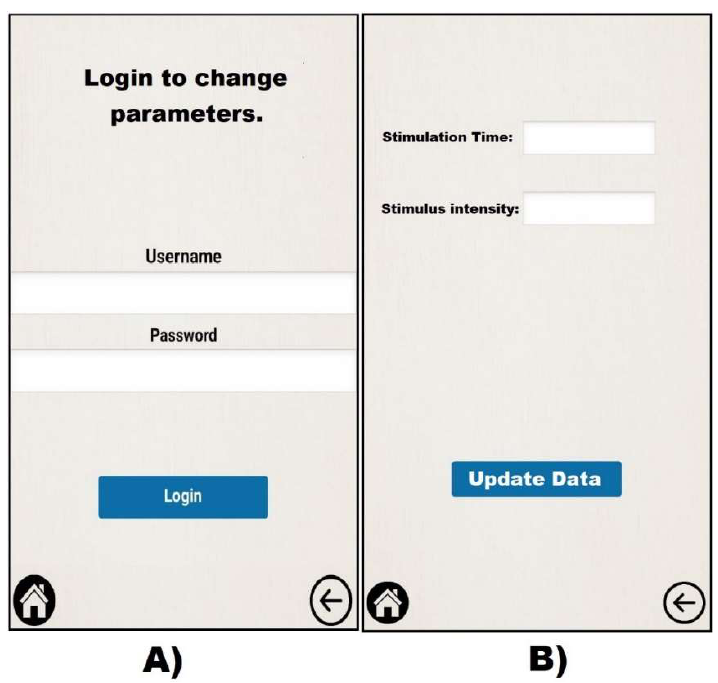
Figure 14. ( A ) Application login window and ( B ) application parameterization window.